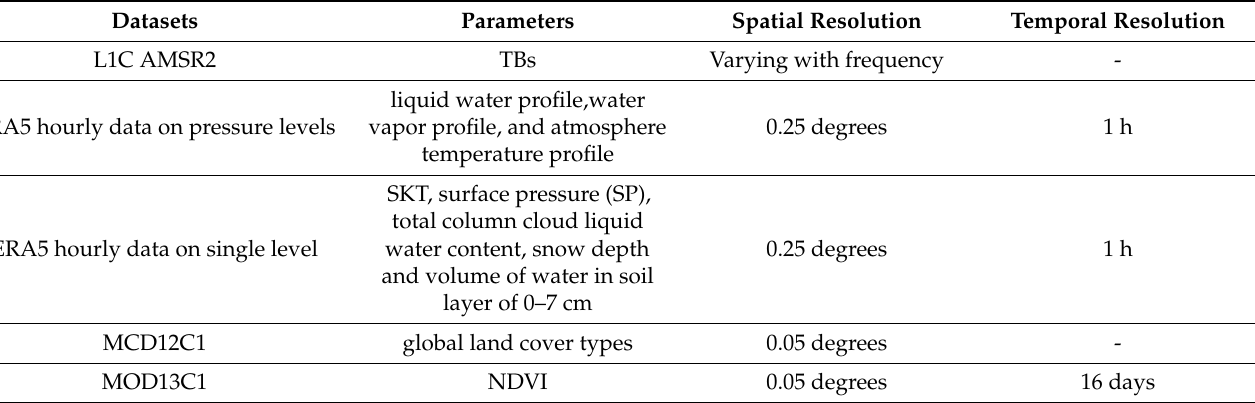
Table 1. The datasets and adopted parameters used in this